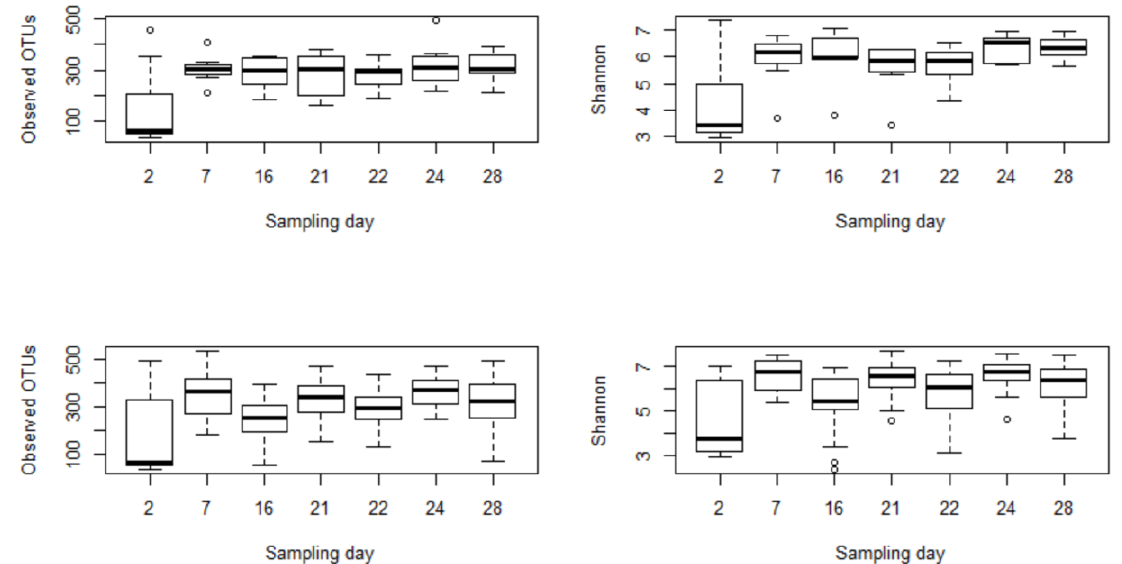
Figure 2. Comparisons of microbial richness (observed OTUs) and evenness (Shannon index) between the control group ( top ) and the combined treatment group ( bottom ) by sampling days. The low and high dose groups were collapsed together into a single treatment group to assess the effects of sampling days on microbial diversities. The difference among sampling days was insignificant in control ( p > 0.05), but it was significant in the treatment group ( p < 0.05). All calves were inoculated with laboratory strains of C. jejuni on day 5; the BRD groups were challenged with M. hemolytica on day 13; and the treatment groups were administered enrofloxacin on day 21.